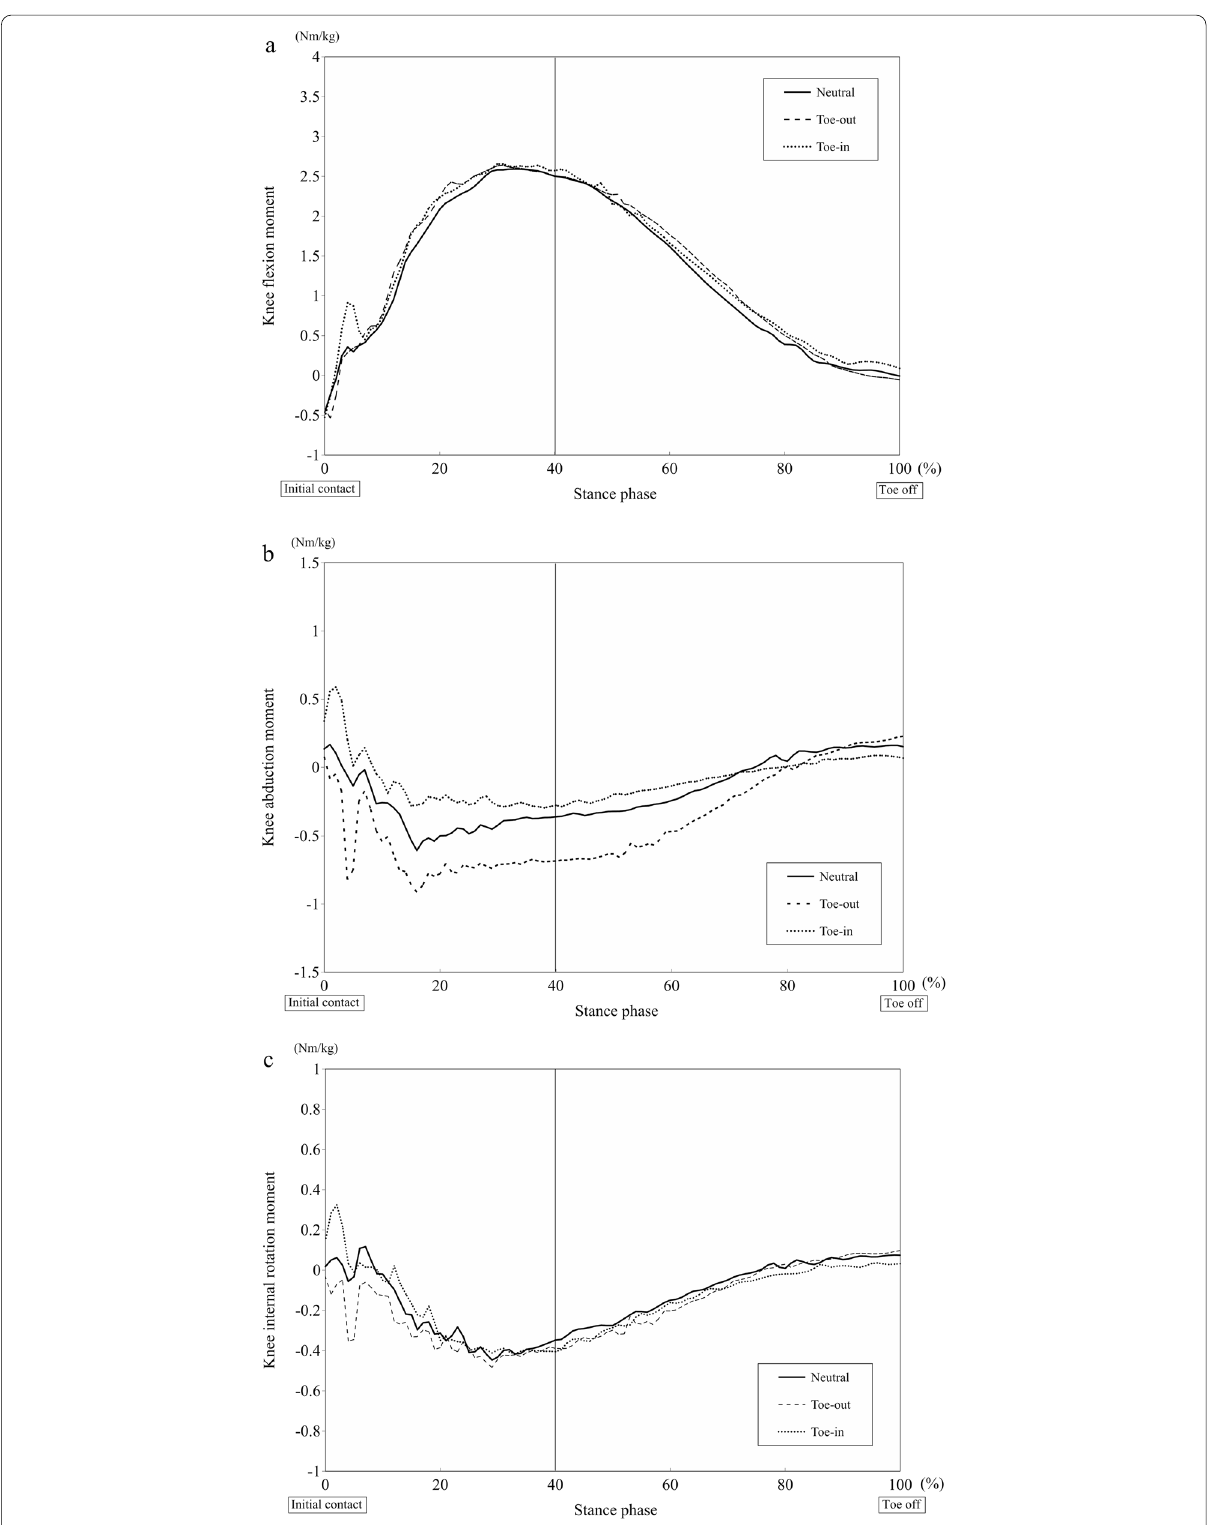
Fig. 4 Waveforms showing the average knee flexion moment ( a ), knee abduction moment ( b ), and knee internal rotation moment ( c ) during the stance phase of the cutting